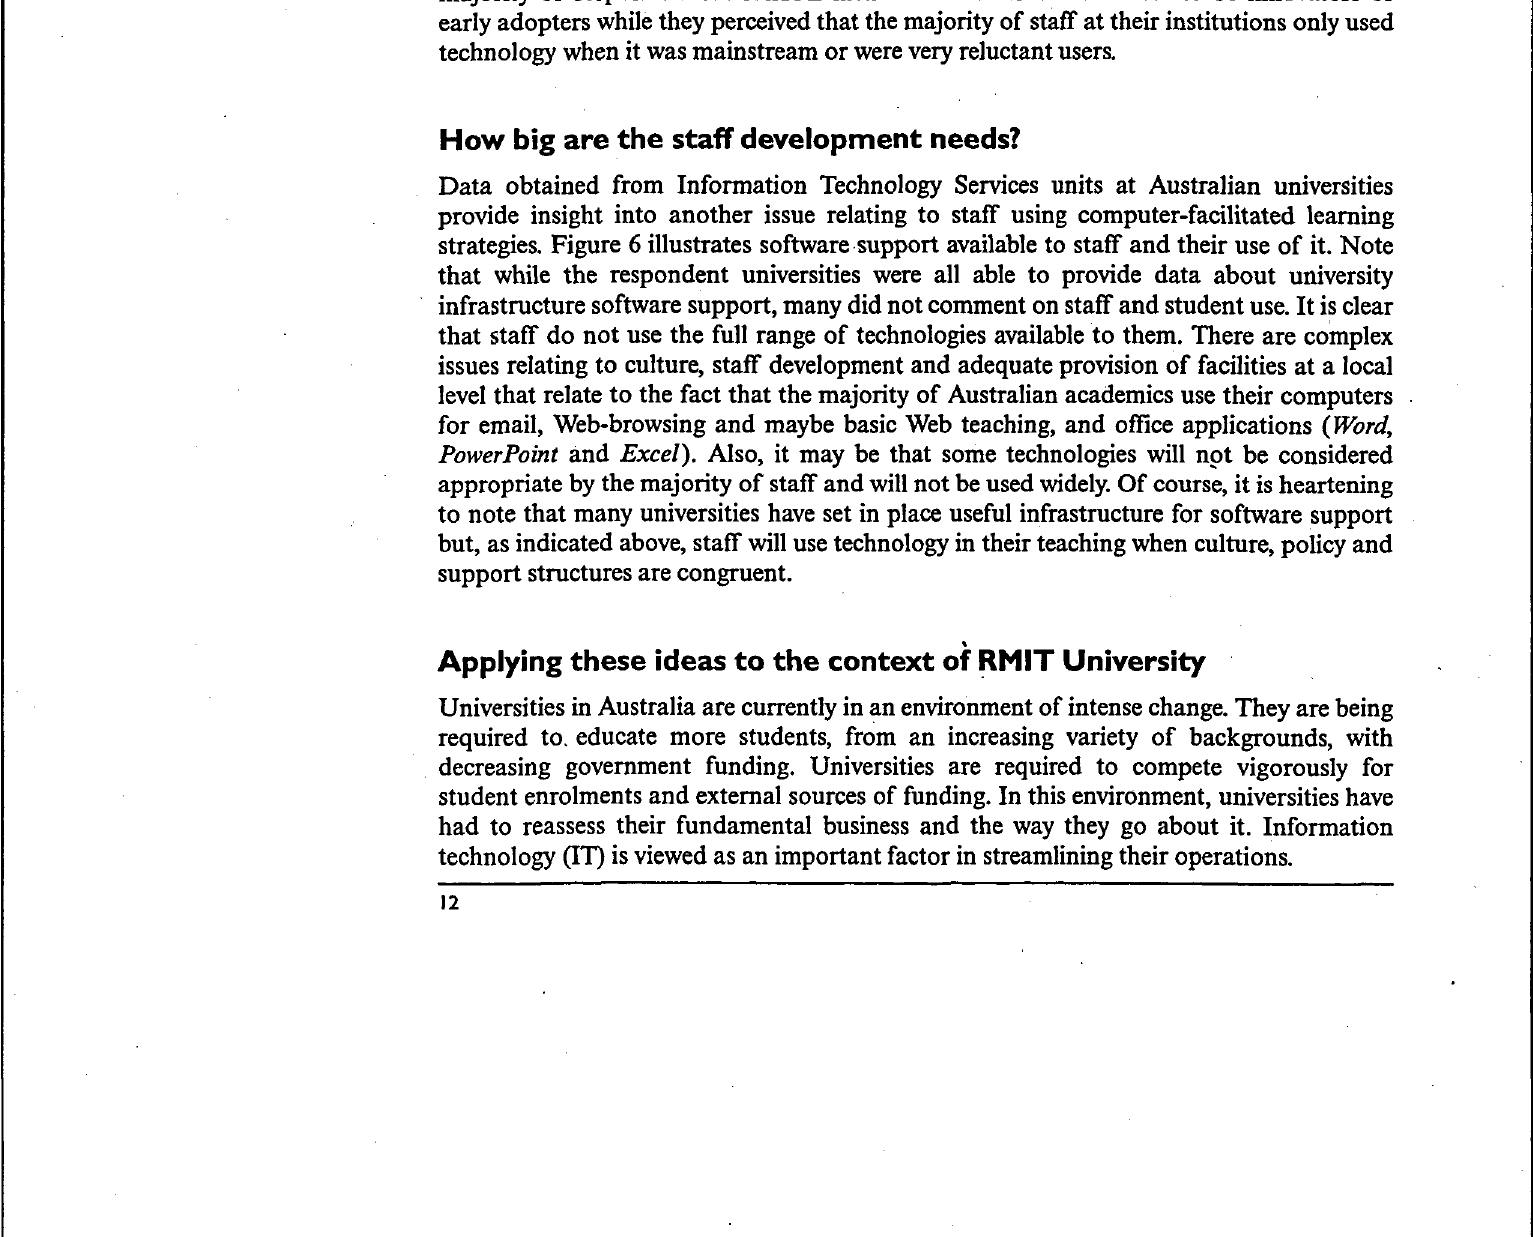
Figure 5: ASC/UTE members' perceptions of CFL adoption